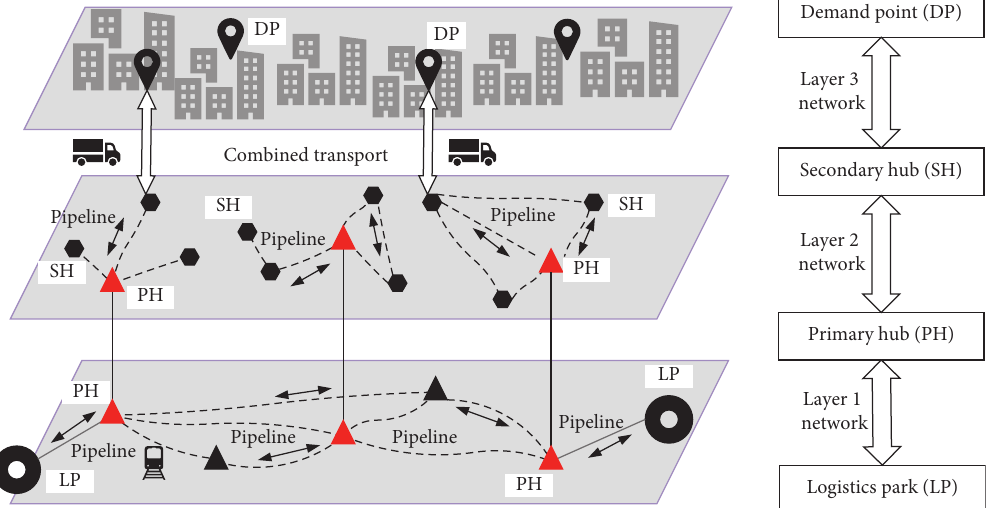
Figure 1: ULS network